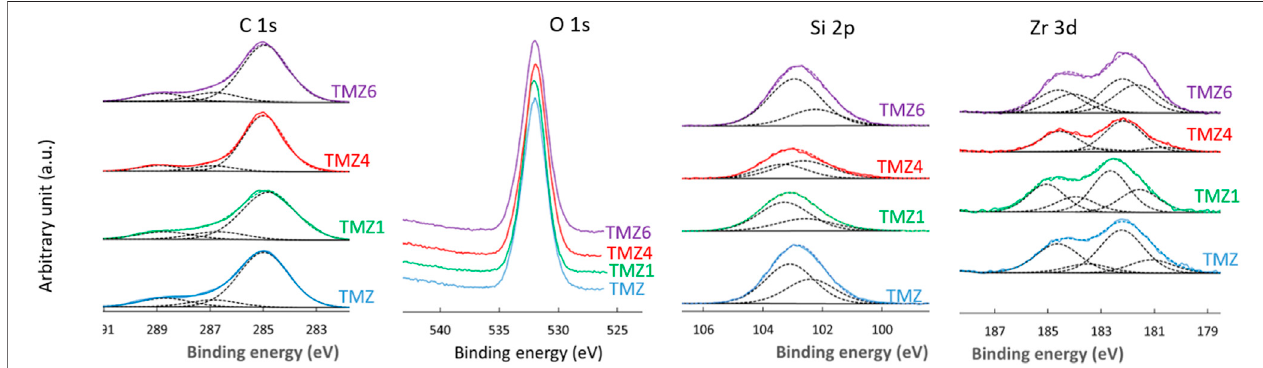
FIGURE9| High-resolutionXPSC1s,O1S,Si2pand Zr3dspectraofaluminiumcoated withTMZcoatingsbeforeimmersionand afterselectedimmersion times in0.1 MNaCl(TMZ1after1 day,TMZ4after4 daysandTMZ6after6 days).TheC1s,Si2pandZr3dspectraweredeconvolutedusingcomponentpeaksasdescribed